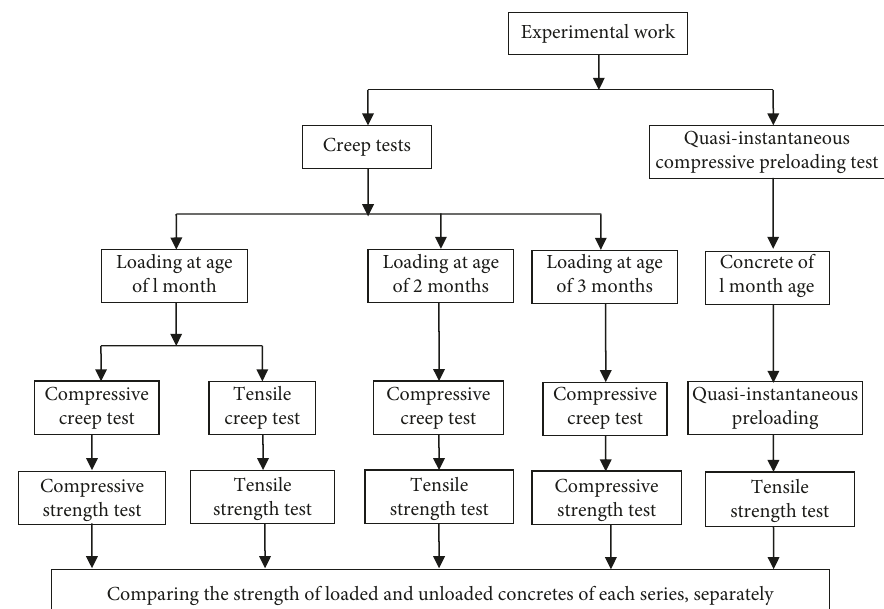
Figure 7: Flowchart of the experimental procedure.